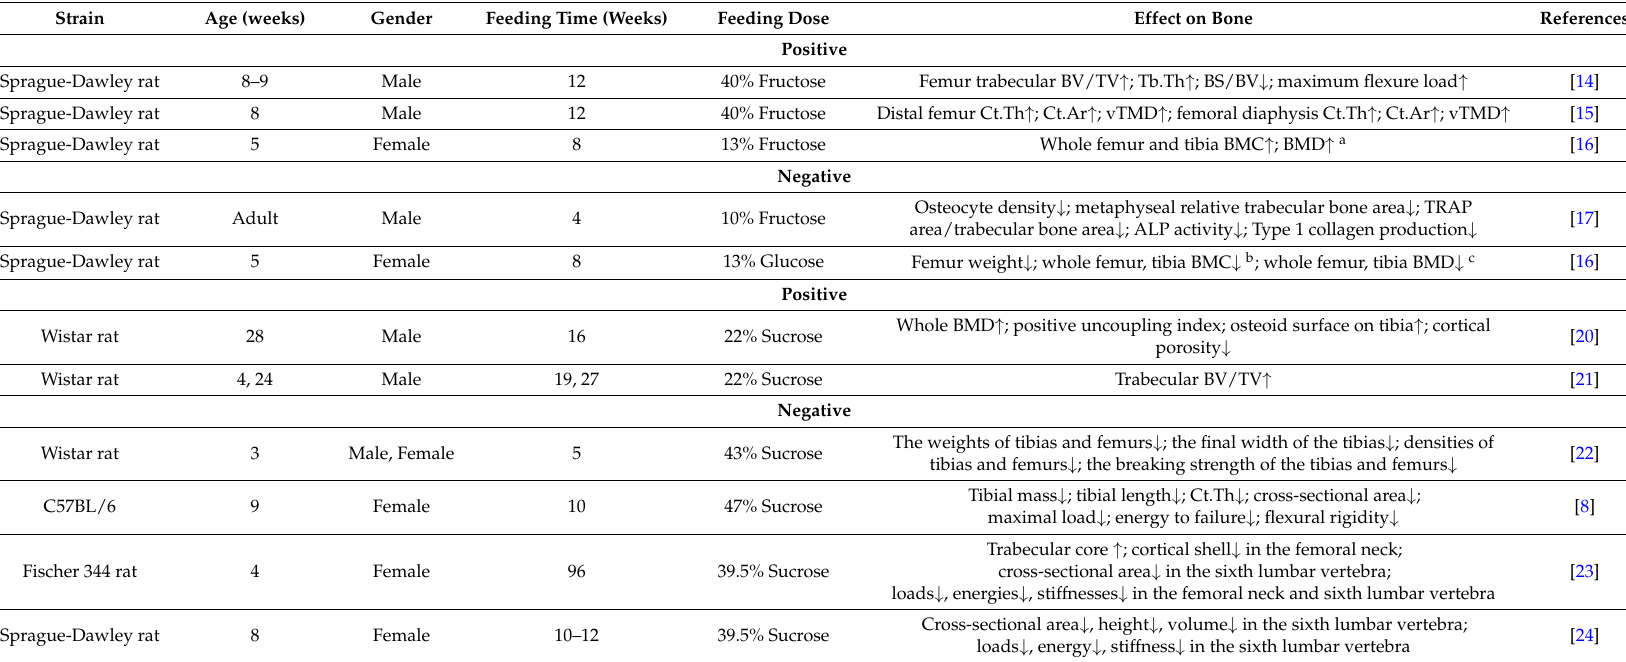
Table 2. Fructose, glucose, and sucrose diet effect on bone